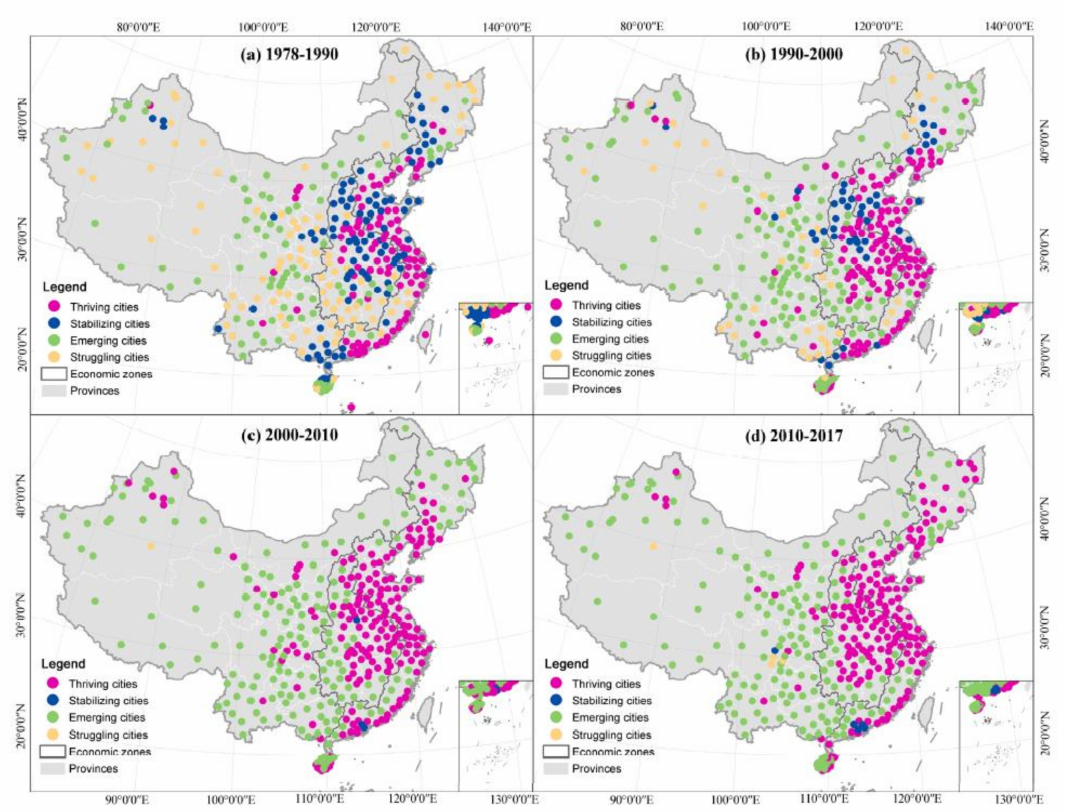
Figure 9. Distribution of thriving, stabilising, emerging, and struggling cities in di ff erent periods: ( a ) distribution of di ff erent types of cities in 1978–1990; ( b ) distribution of di ff erent types of cities in 1990–2000; ( c ) distribution of di ff erent types of cities in 2000–2010; ( d ) distribution of di ff erent types of cities in